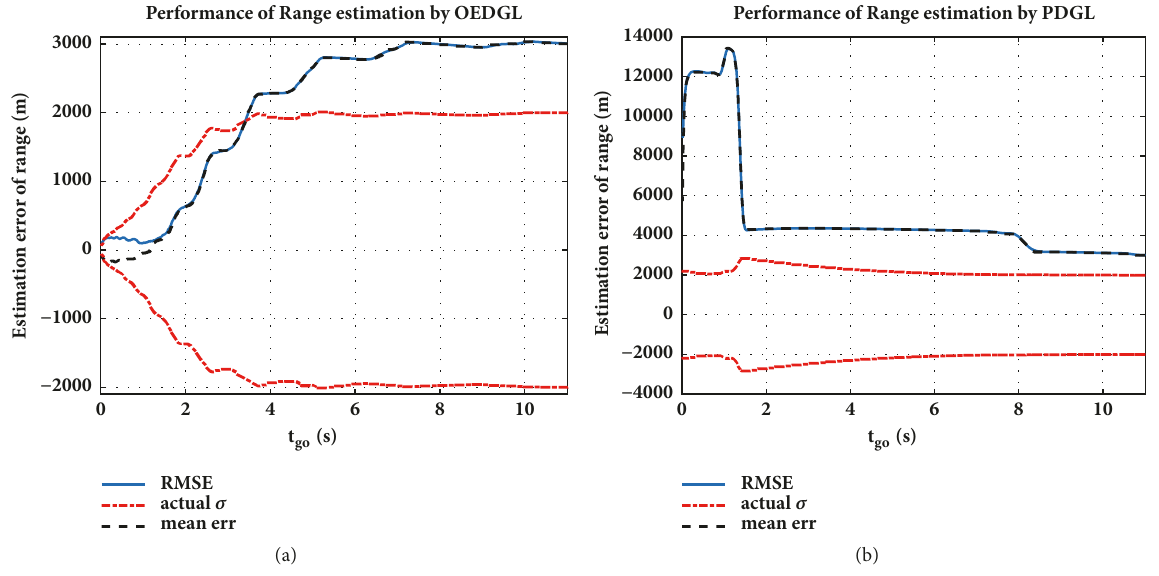
Figure 3: The performance comparison of range estimation between OEDGL and